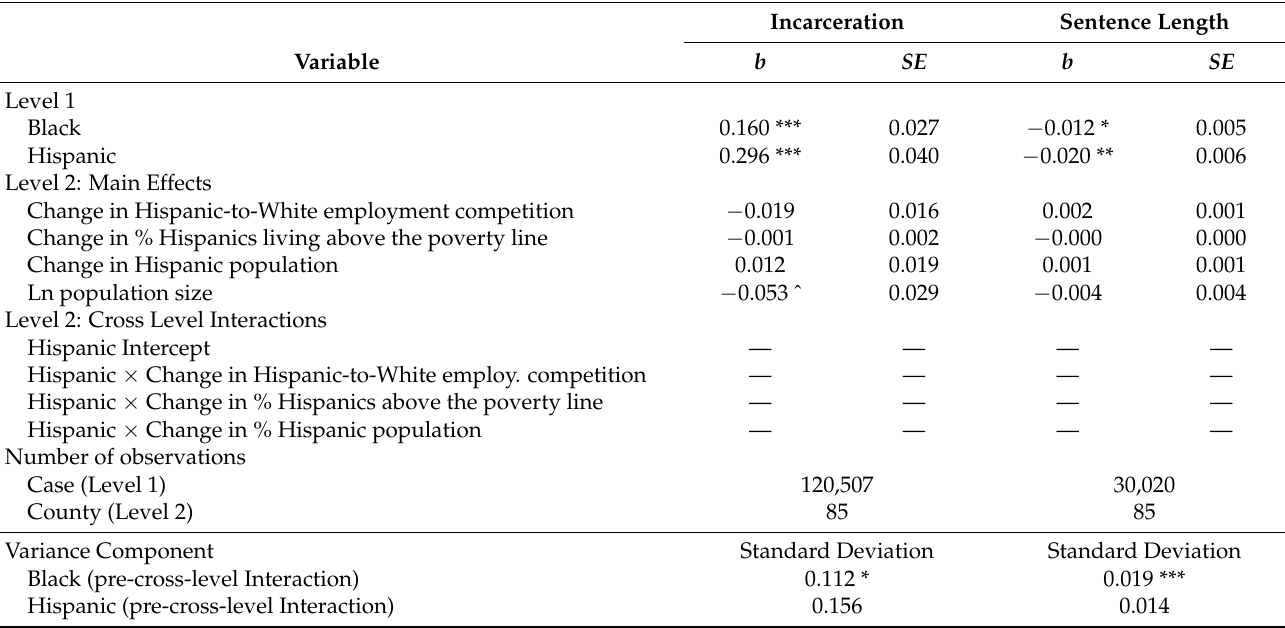
Table 5. Hierarchical Regression Model of Incarceration and Sentence Length, Case-Level, County-Level Effects, and Cross-Level Interactions for Hispanic